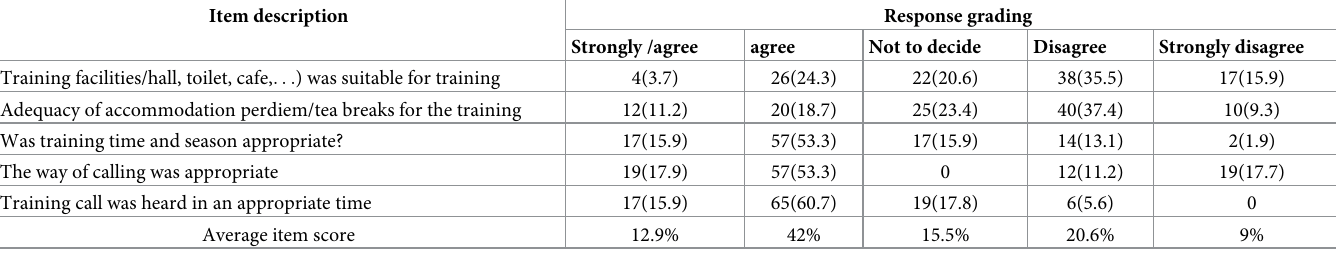
Table 7. Respondents’ description of training set-ups, benefits and finance-related factors in Amhara Public Health Institute Dessie Branch, northeast Ethiopia, October/2019 (N = 107). Item